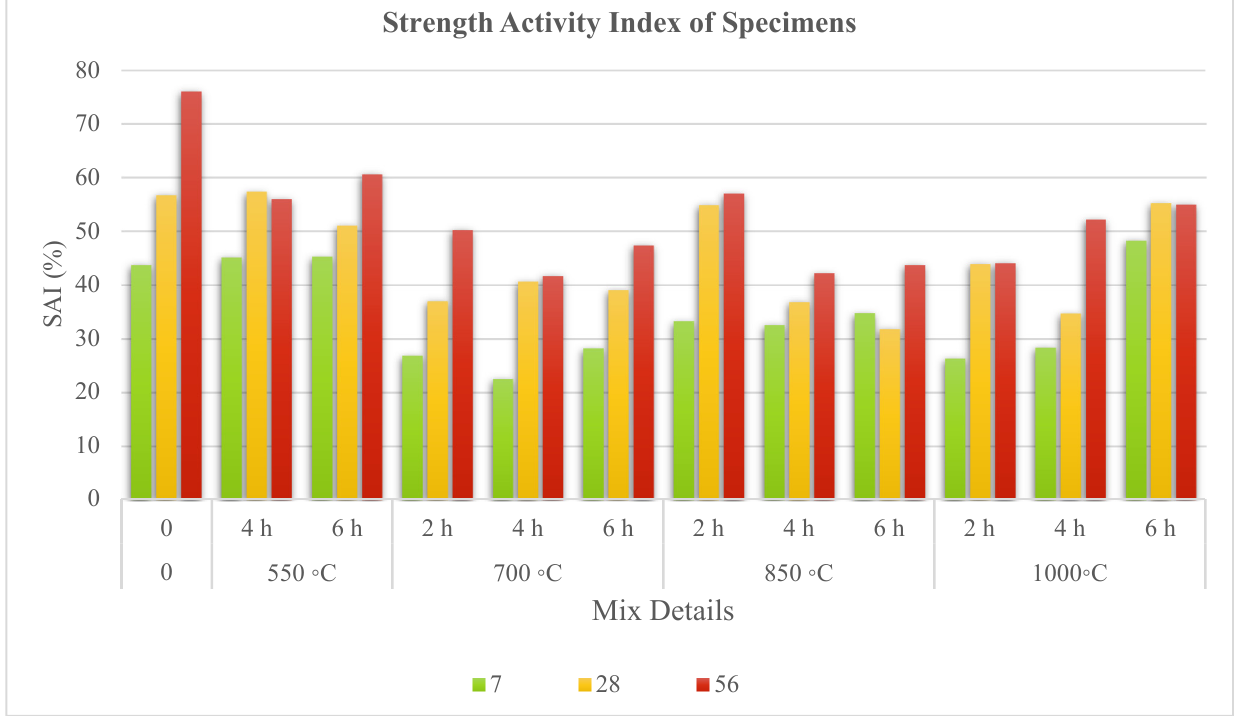
Figure 10. Effect of pre-treatment on strength activity index of samples containing 20% ash as cement re-placement.